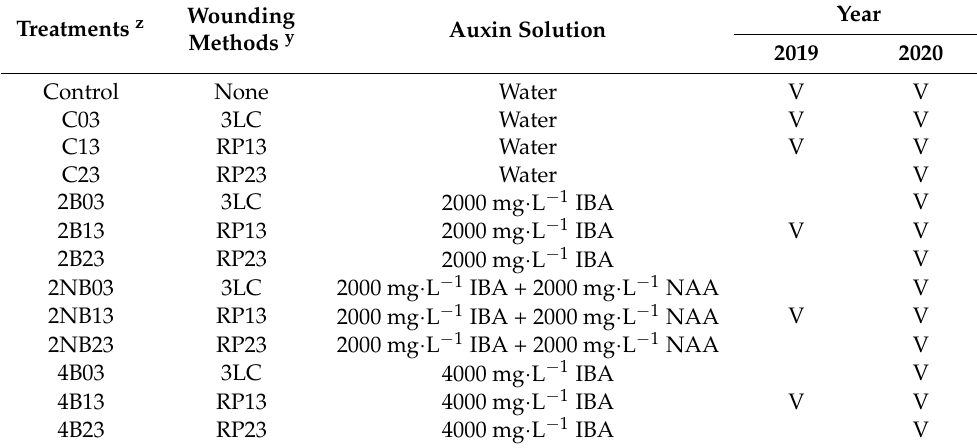
Table 1. Wounding/auxin treatments in 2019 and 2020. Each treatment had six replicates in 2019 and twelve replicates in